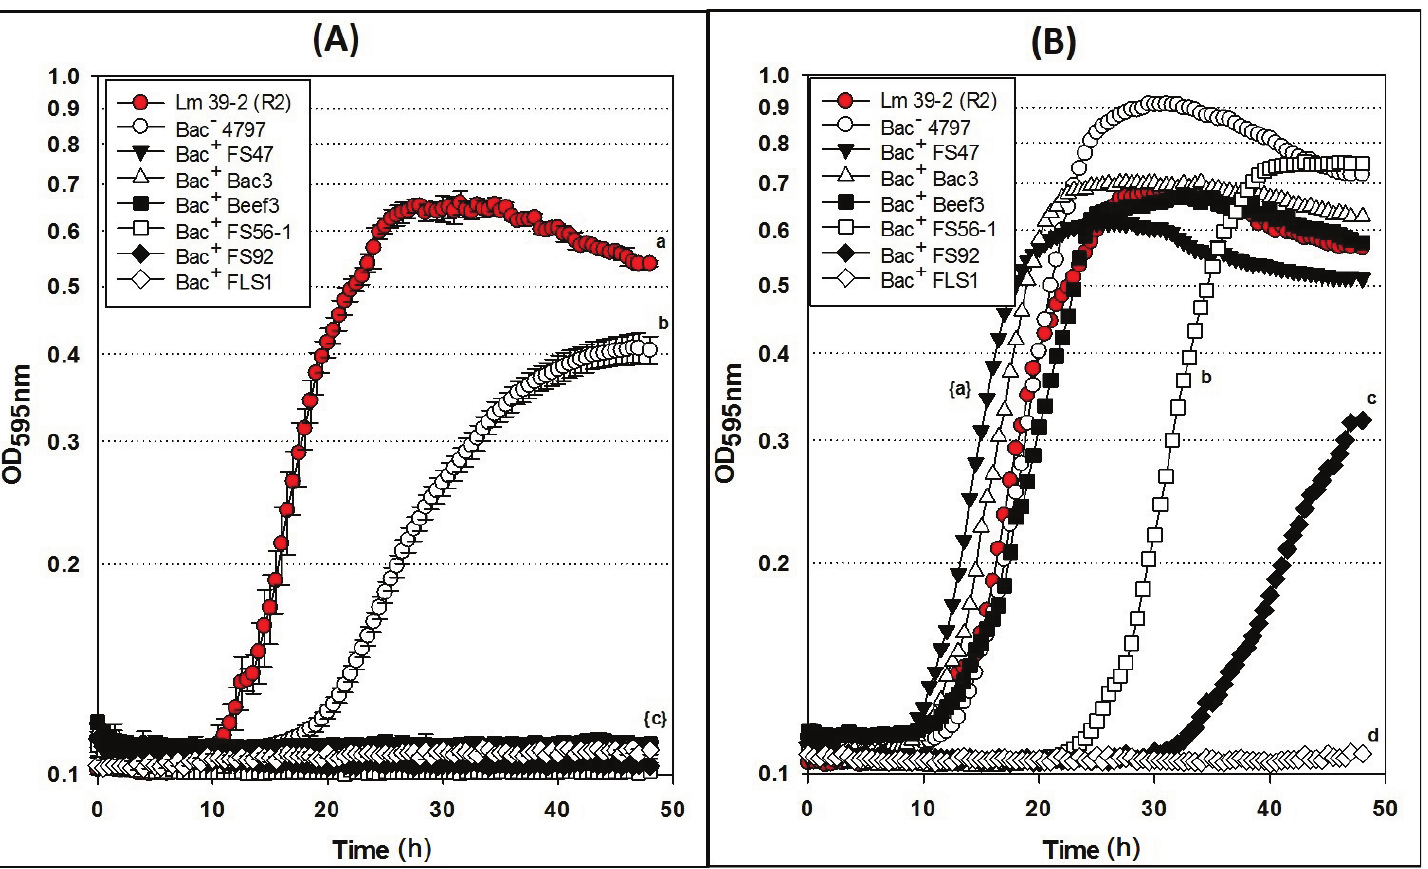
Figure 6. Microplate growth inhibition assays showing the activity of Listeria monocytogenes 39-2 (R2) treated with culture supernatants from: None (R2 Cont.), Lb. delbrueckii 4797-2 (Bac (cid:2) ), Lb. curvatus FS47, P. acidilactici Bac3, Lb. curvatus Beef3, En. faecium FS56-1, En. thailandicus FS92, and Lc. lactis FLS1. ( A ) Microplate assay using non-neutralized culture supernatants; ( B ) Microplate assay using neutralized culture supernatants. Data points represent the means of triplicate replications and error bars represent the standard deviations from the means (error bars were not used for all curves in order to prevent clutter). Treatments with different lowercase letters are significantly different ( p < 0.05); letters in brackets are for entire group of graph